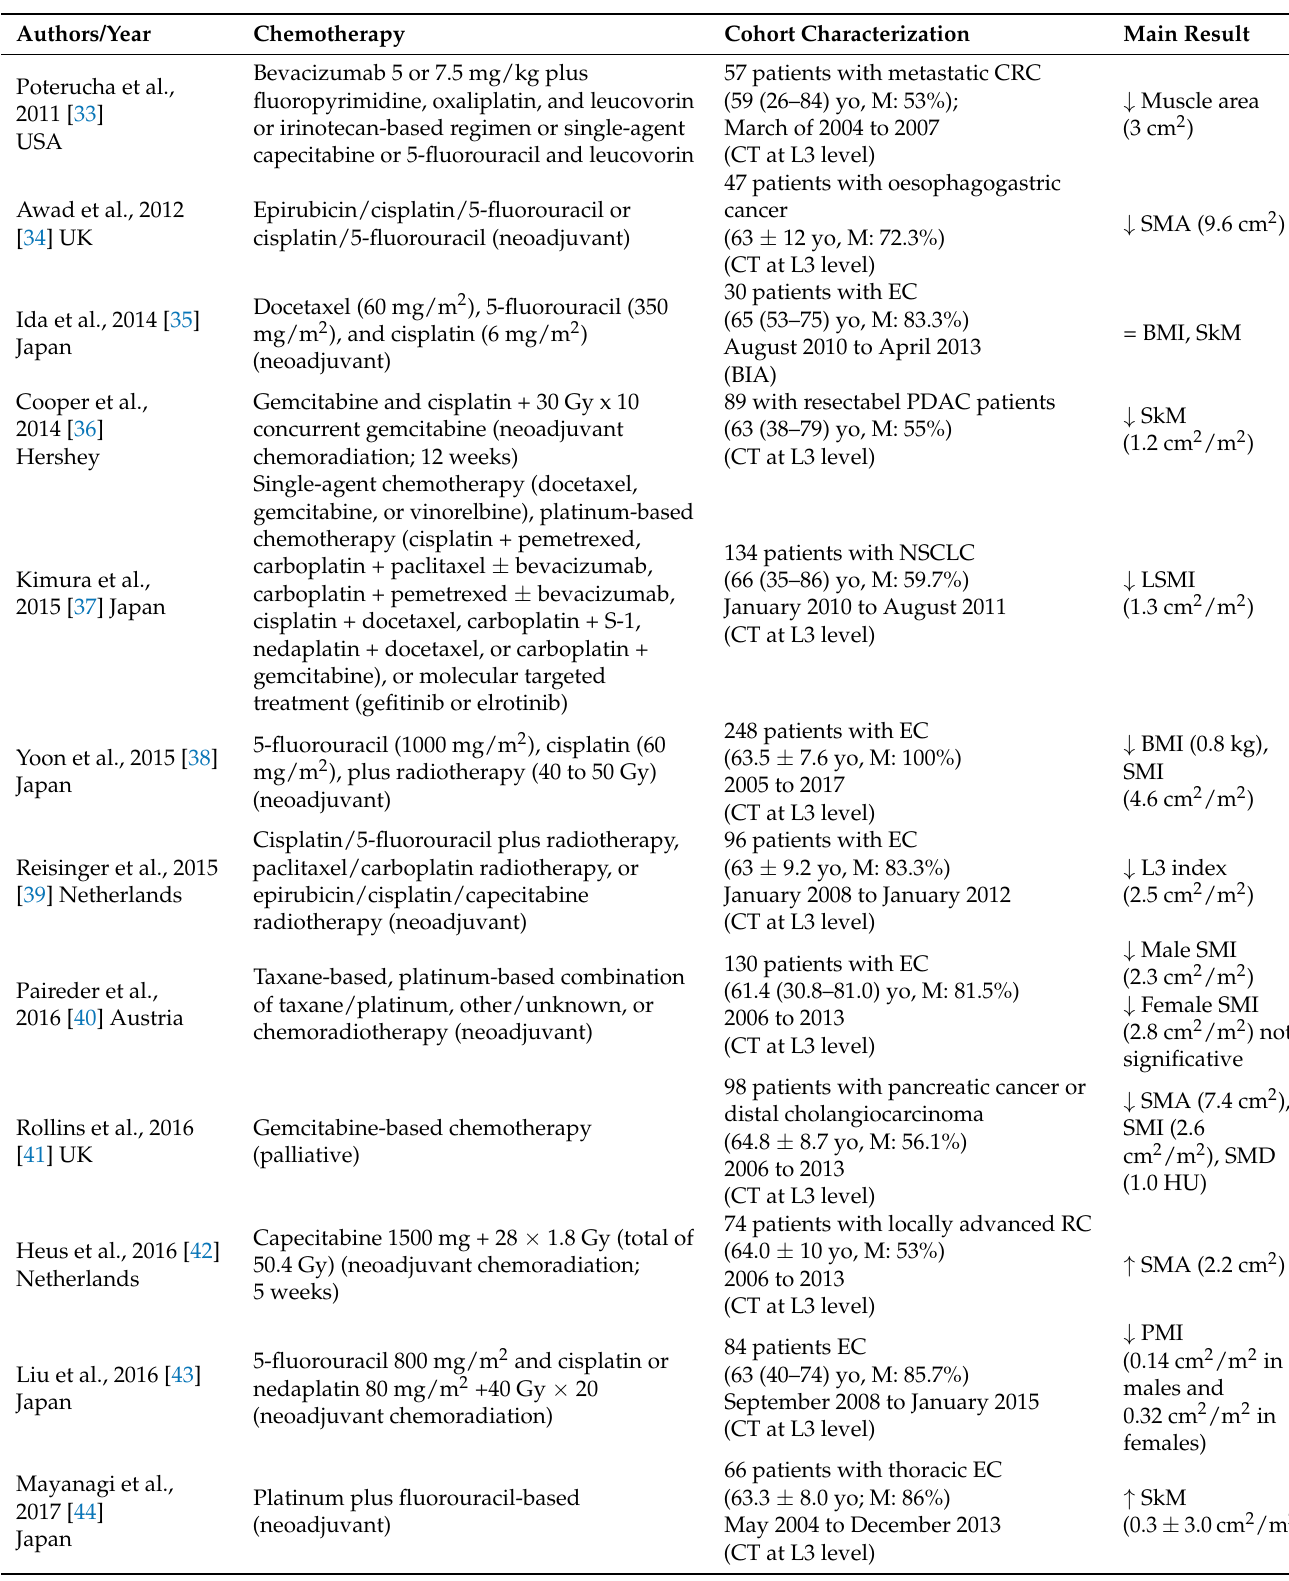
Table 2. Effects of chemotherapy in cancer